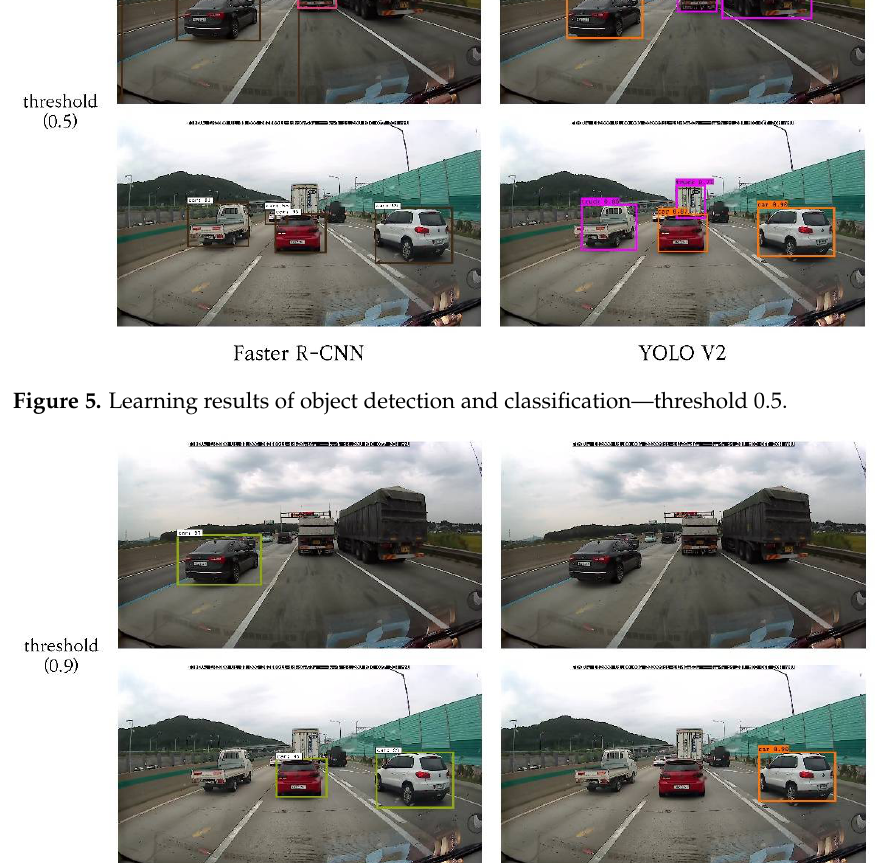
Figure 7. Learning results of object detection and classification—threshold 0.7.